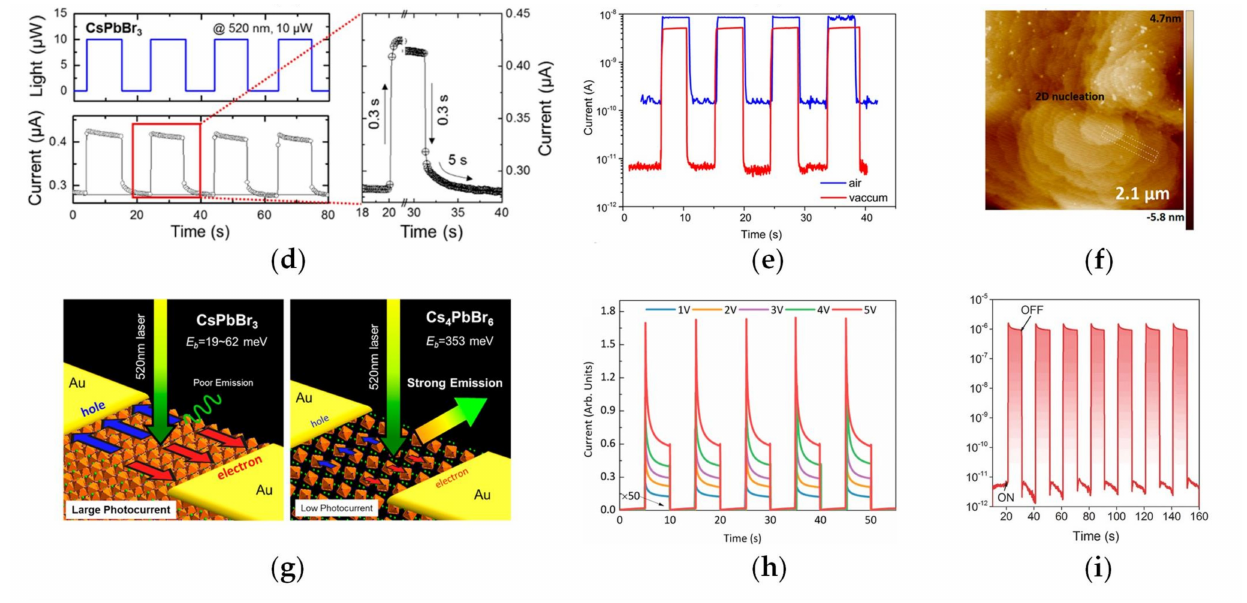
Figure 9. ( a ) Measurement results of I − T curve of detectors under bias of 2 V voltage and rise and decay time measurement result. Adapted with permission from Ref. [150]. 2017, John Wiley and Sons; ( b ) photoresponse test result of CsPbBr 3 PSC photodetector fabricated by Zhang et al. at different wavelengths. Adapted with permission from Ref. [54]. 2017, American Chemical Society; ( c ) structure of the detector made of CsPbBr 3. Adapted with permission from Ref. [84]. 2017, American Chemical Society; ( d ) measurement results of I-T curve of detectors and rise and decay time test result. Adapted with permission from Ref. [84]. 2017, American Chemical Society; ( e ) light-to-dark test results of the Cs 2 InAgCl 6 PSC detectors under 365 nm monochromatic. Adapted with permission from Ref. [103]. 2018, American Chemical Society; ( f ) AFM image of two-dimensional nucleation on CsPbBr 3 PSC (101) plane. Adapted with permission from Ref. [145]. 2017, American Chemical Society; ( g ) schematic diagram of photocurrent production and the PL emission process in 0D Cs 4 PbBr 6 and 3D CsPbBr 3 PSCs . Adapted with permission from Ref. [84]. 2017, American Chemical Society; ( h ) measurement results of I-T curve of CsPbBr 3 PSC detectors under different voltage bias. Adapted with permission from Ref. [145]. 2017, American Chemical Society; ( i ) on-off ratio test result (I-T curve) of CsPbBr 3 PSC detectors. Adapted with permission from Ref. [43]. 2016, John Wiley and